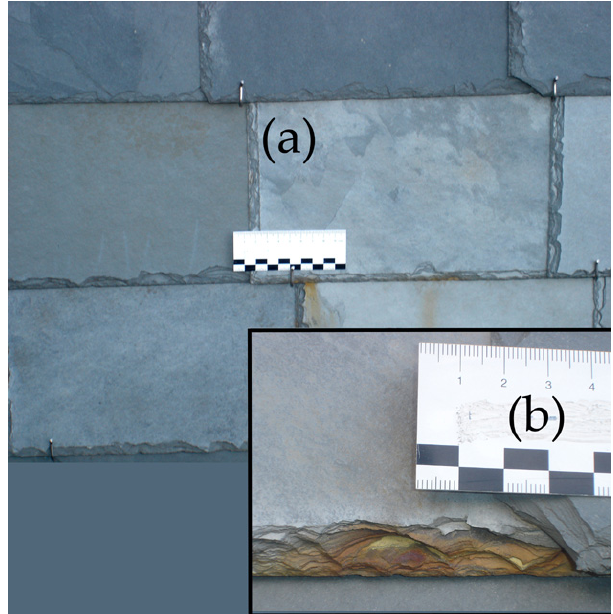
Figure 7. The cleavage of the shale does not originate from real schistosity but from a fine stratification ( a ). (See picture detail on the lower right ( b )) (At the time of the photo a nearly new cladding.); Minas Gerais (oliv-grey) / Brazil.